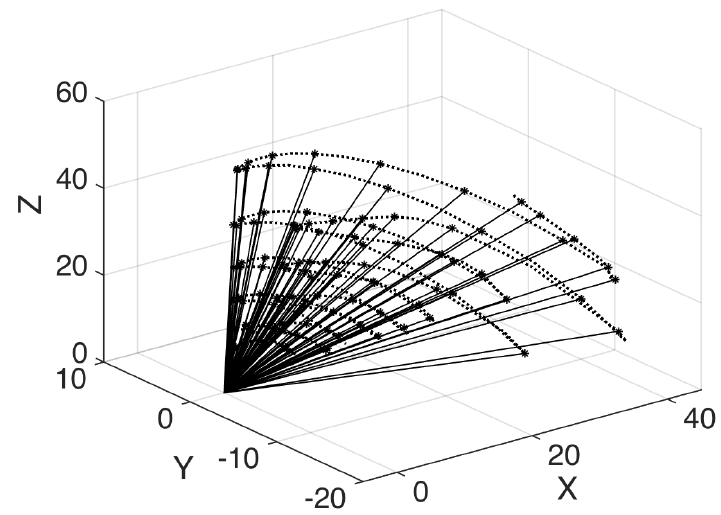
Figure 7. Optimal trajectory in